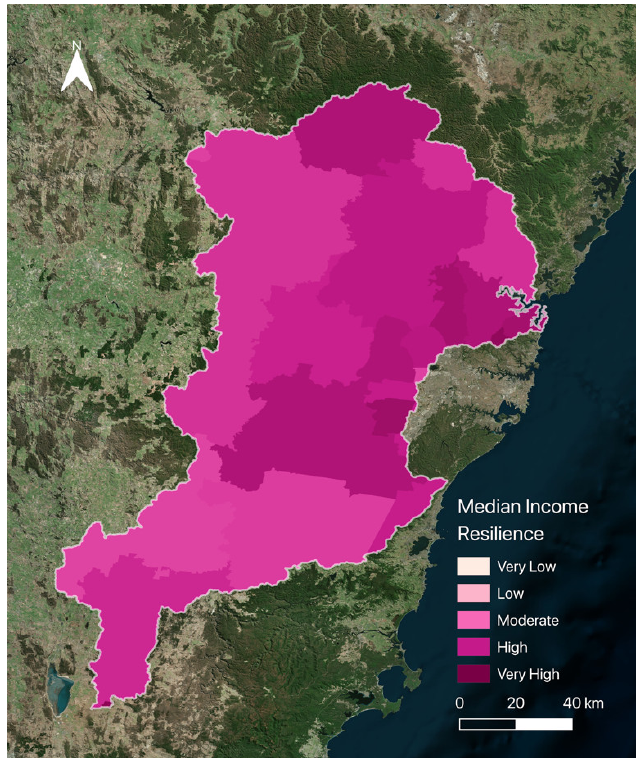
Figure 10. Median Income Resilience after standardising using fuzzy membership processing. Re- silience measured from Very Low (light pink) to Very High (dark pink).